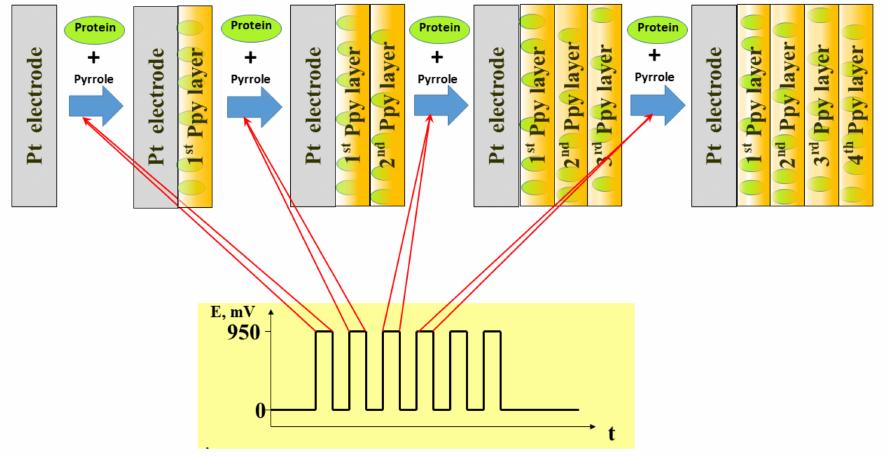
Figure 2. Electrochemical deposition of polypyrrole with simultaneously entrapped proteins using potential pulse-based technique, figure adapted from [50].